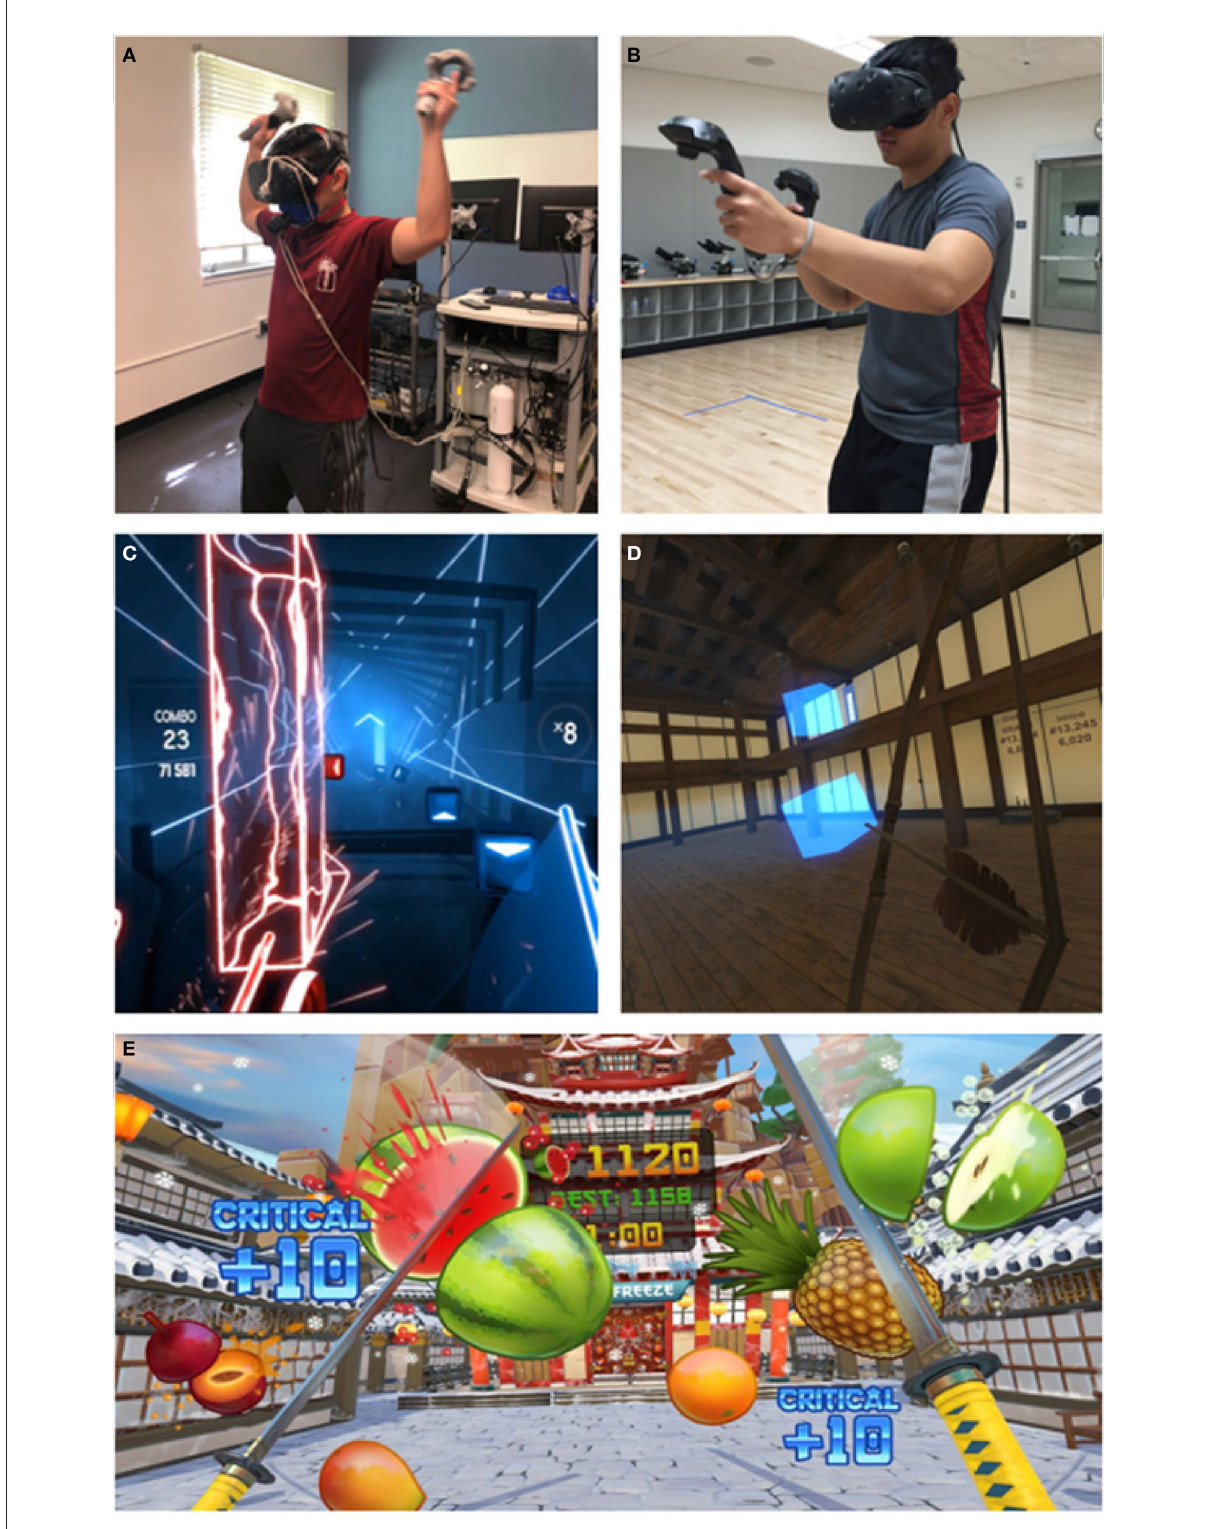
FIGURE1 Experimental setup in exercise settings and in-game active virtual reality (VR) scenes. (A) Laboratory Setting (LabS), (B) Gym/Recreation Center Setting (GymS), (C) Gameplay during Beat Saber (Beat Games, Prague, CZ), (D) Gameplay during Holopoint (Azlan Studios, Florida, USA), (E) Gameplay during Fruit Ninja VR (Halfbrick Studios. Brisbane,